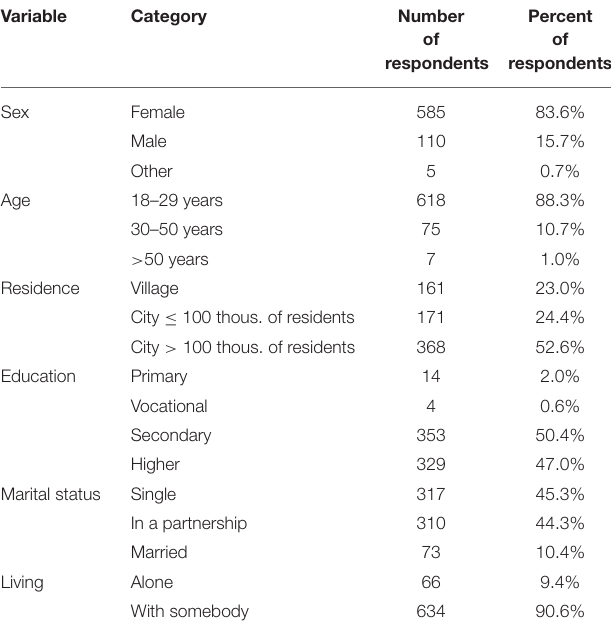
TABLE 1 | Demographic features of the surveyed group of poles ( N =